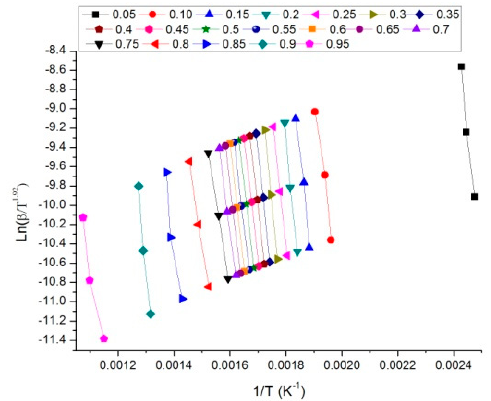
Figure 2. Linear plots in the 0.05–0.95 conversion range for determining activation energy of solid digestate, calculated according to the Starink method.